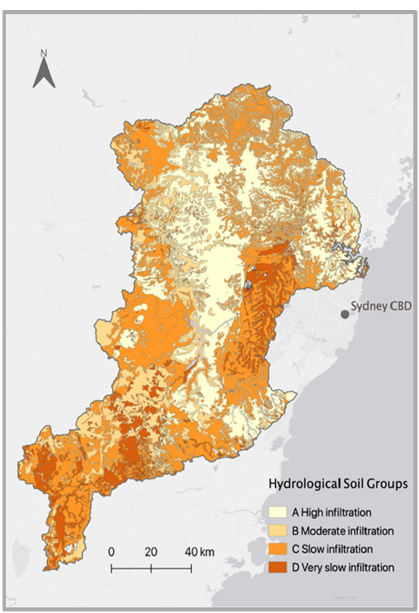
in Figures 10 and 11, respectively.